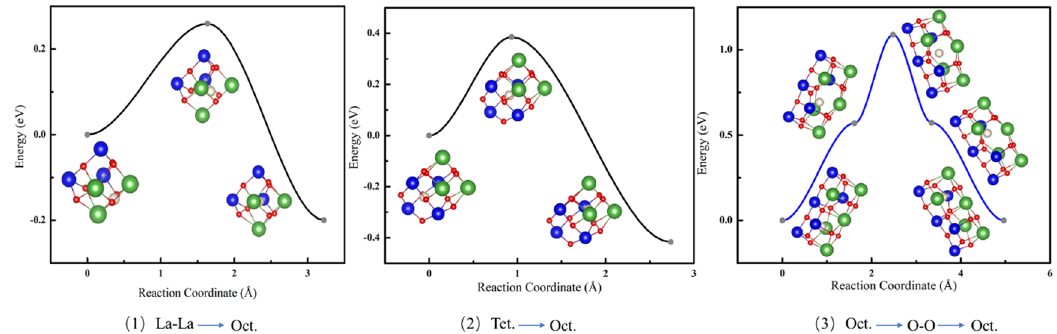
Figure 2. Migration pathway for He atom from ( 1 ) La-La interstitial site, ( 2 ) tetrahedral interstitial site and ( 3 ) O-O interstitial site to octahedral interstitial site. The local La 2 Zr 2 O 7 pyrochlore structures including a He atom are illustrated in the figure, the green, blue, red and ivory spheres represent La, Zr, O and He atoms, respectively.